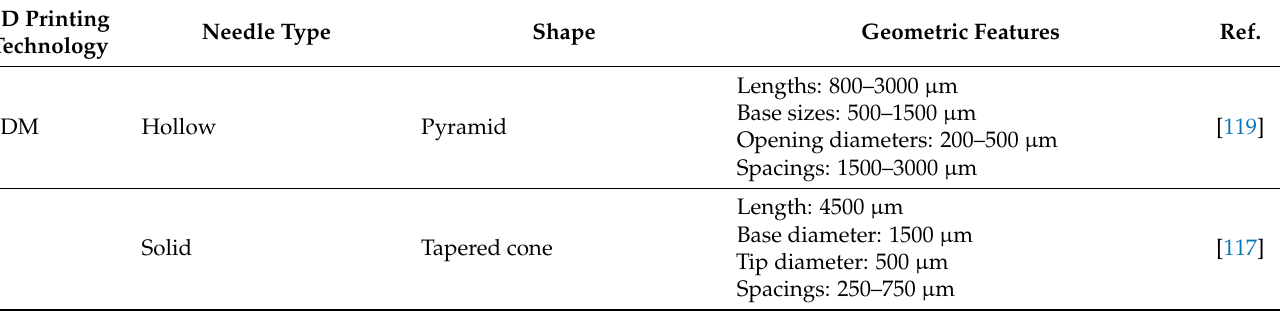
Table 2. 3D-printed microneedles for transdermal drug